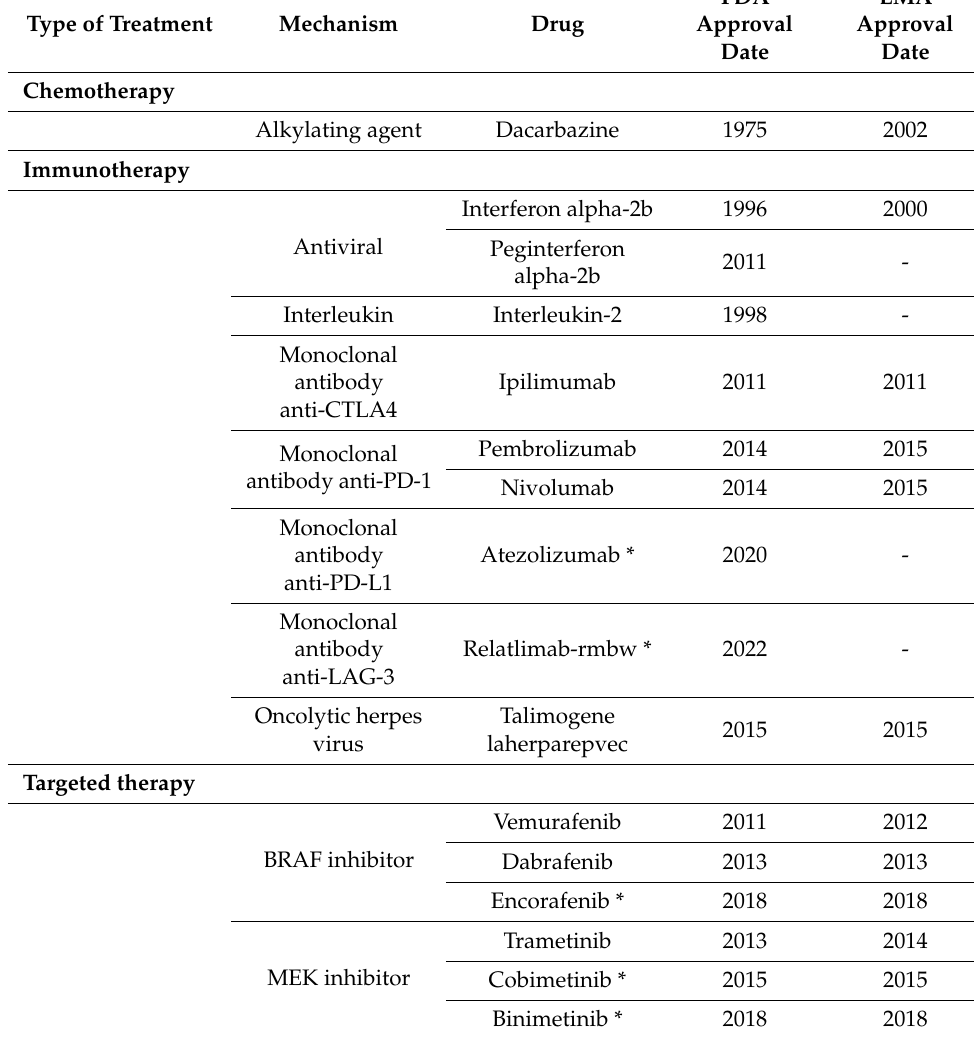
Table 2. Melanoma treatment drugs and respective years of approval by Food and Drug Administra- tion (FDA) and European Medicines Agency